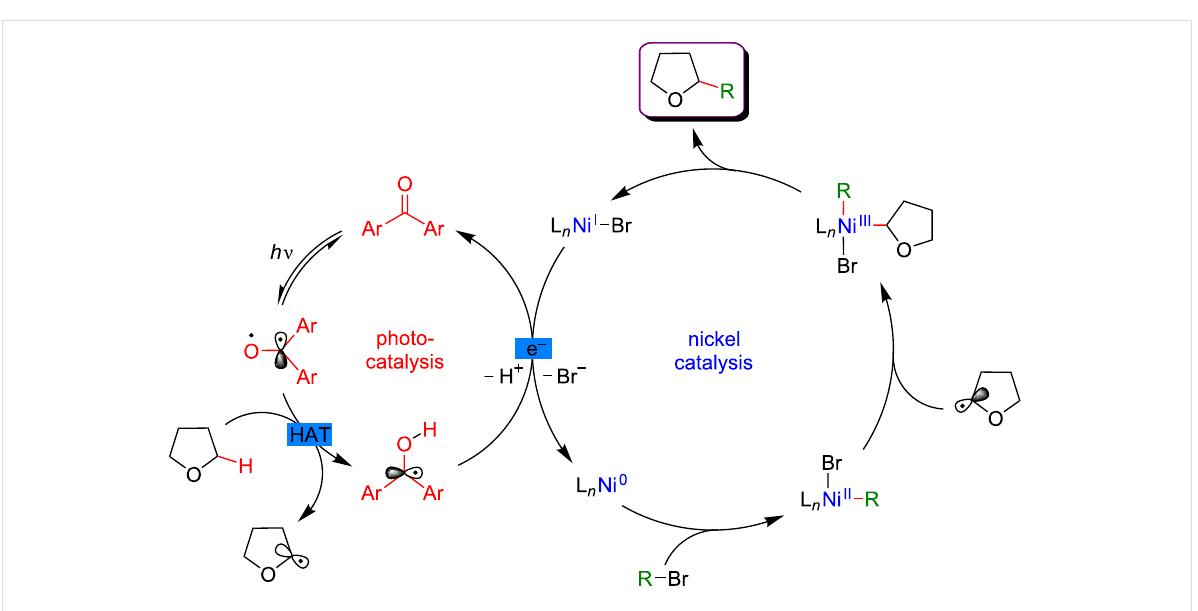
Figure 63: Proposed mechanism for the C–H functionalization enabled by excited